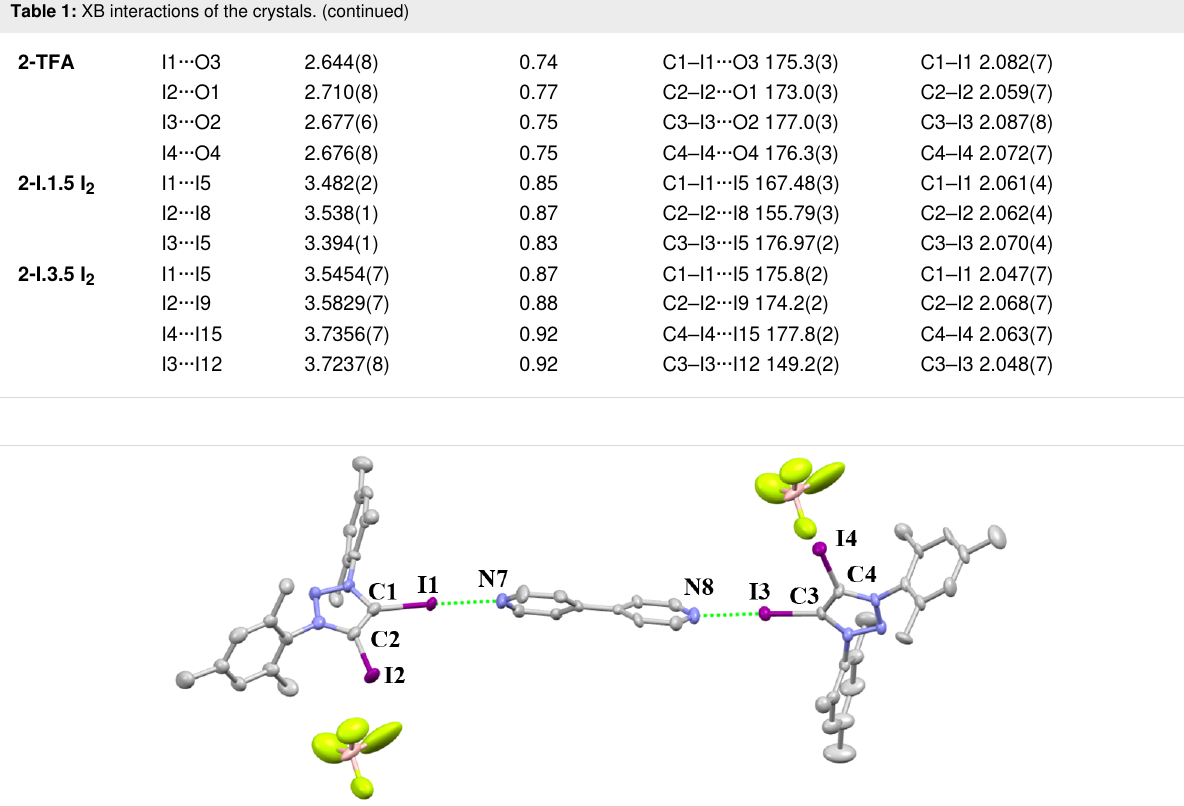
Table 1: XB interactions of the crystals. (continued)